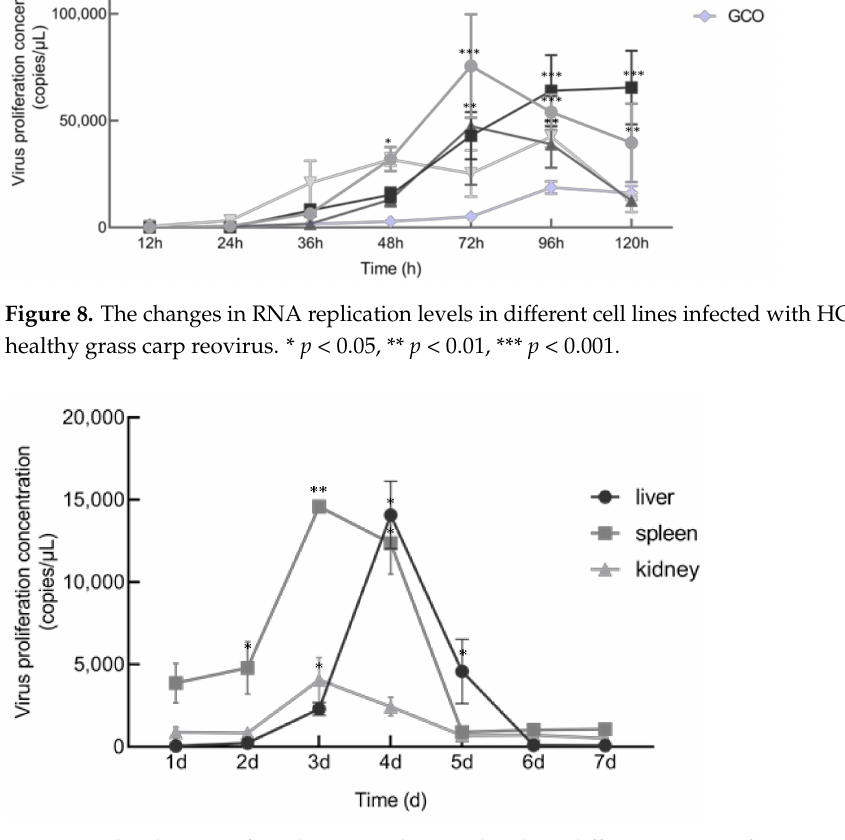
Figure 9. The changes of viral RNA replication levels in different tissues of HGCRV-infected grass carp. HGCRV, healthy grass carp reovirus. * p < 0.05, ** p <